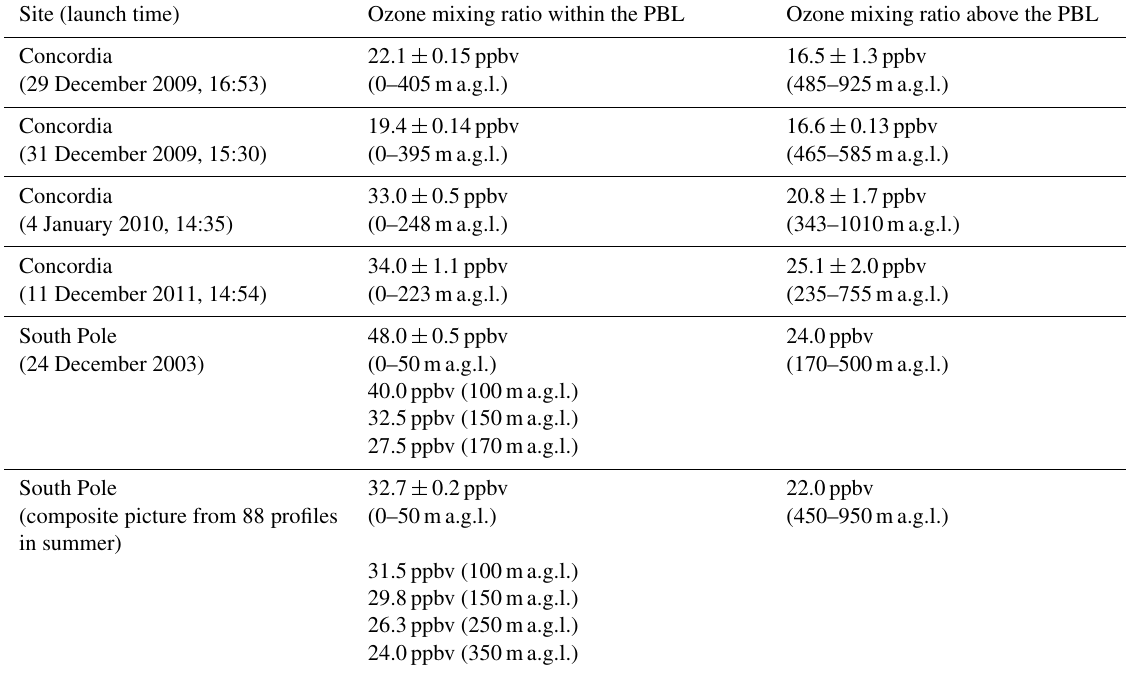
Table 2. Comparison of typical vertical gradient of ozone above the ground at Concordia in summer in the afternoon and those observed at the South Pole. Heights are given in ma.g.l. For the South Pole, we report the composite based on 88 profiles obtained during summer months between 1991 and 2005 showing vertical gradient of more than 8ppbv (Oltmans et al., 2008) and the case of 24 December 2003 characterized by a mixing ratio close to 50ppbv near the surface, reported by Helmig et al.